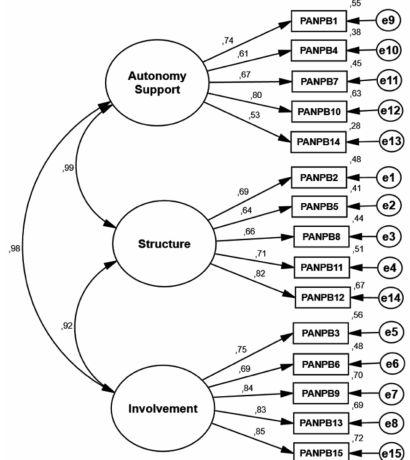
Figure 1. Standardized individual parameters (covariance factors. factorial weights and measurement errors), all of which were significant in the measurement model (PESSp - three factors/15 items) for the Portuguese calibration sample